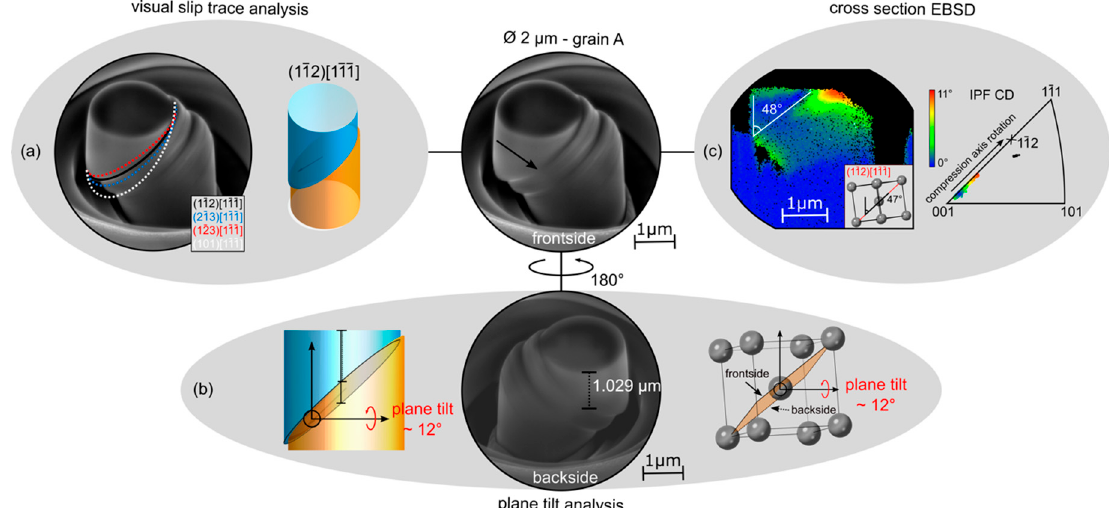
Figure 7. Three different slip system analysis methods demonstrated on a BCC Fe-2.4wt%Si micropillar. ( a ) showing the visual slip trace analysis conducted on a pillar tilted to 45°. This is supported by a cylindrical MATLAB model utilising the toolbox MTEX, ( b ) plane tilt analysis utilising the same MATLAB model and VESTA [49] to visualise the tilt of a slip plane in an edge on view (effectively a 90° tilt) compared to a calculated value from measurements of two SE-images taken from opposite sides, ( c ) cross section EBSD results: misorientation deviation map with indicated slip plane angle as well as IPF triangle relative to the compression direction (CD) with indicated relative rotation of the compression axis towards the ( hkl ) pole of the identified slip plane, the slip plane positions and the corresponding colour codes including scales for the orientation deviation/axis rotation. Image reproduced from [8] .